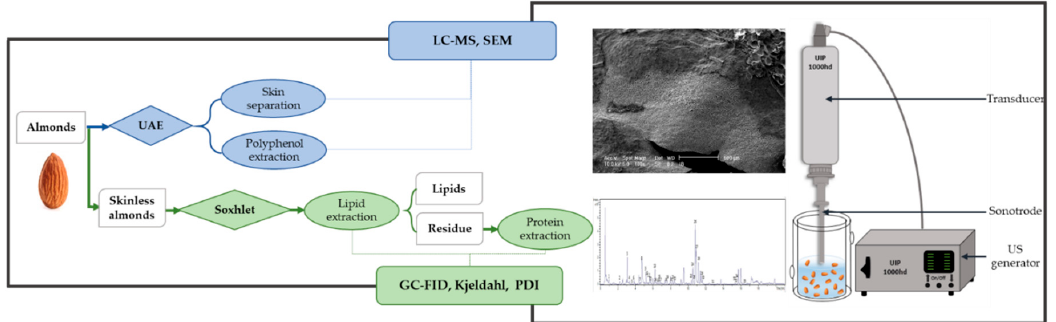
Figure 1. Graphical illustration of the experiment’s design.